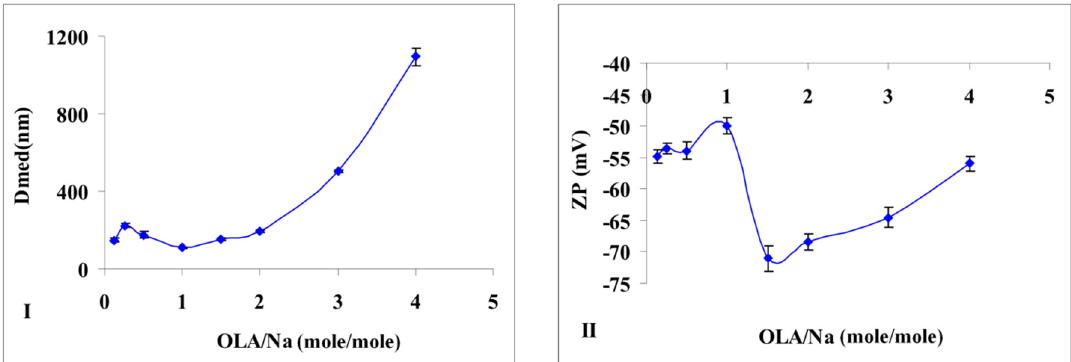
Figure 2. ( I ) Size modification of the dispersions prepared at a fixed amount of sodium silicate and different quantities of OLA; ( II ) Zeta potential modification of the dispersions prepared at a fixed amount of sodium silicate and different quantities of OLA (Dmed represents the medium/average diameter recorded for the prepared silica dispersions).